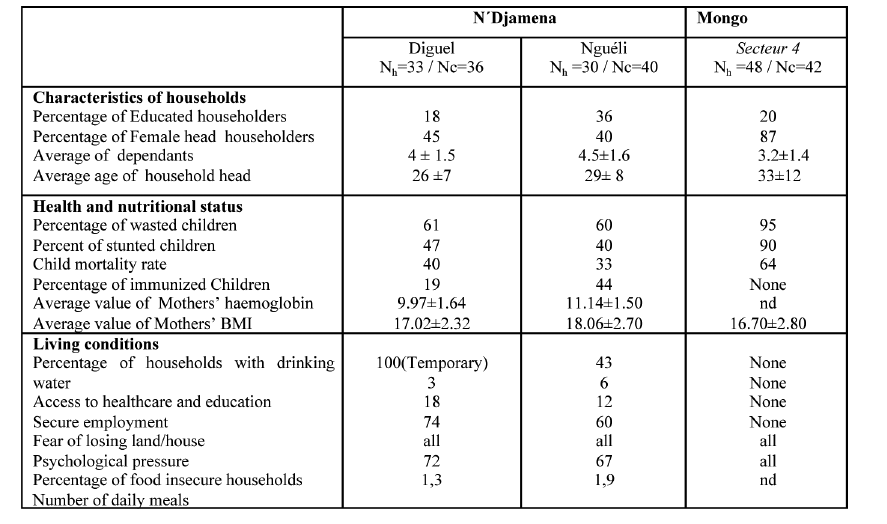
Table 1: Socio-demographic, nutritional and health characteristics of the three study areas